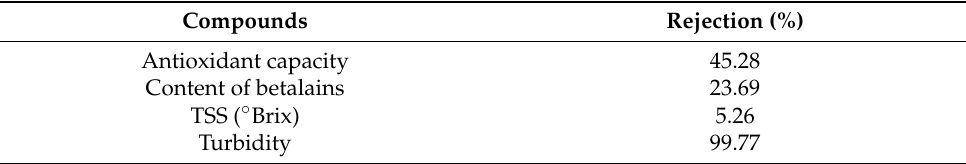
Table 4. Rejection of the compounds by the microfiltration membrane.